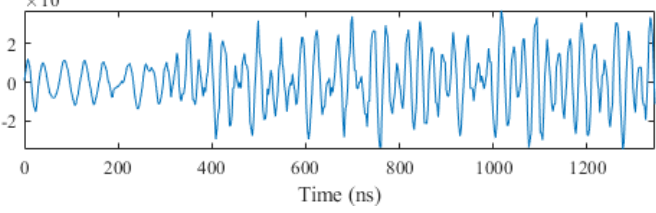
Figure 12. A single trace of the GPR dataset.